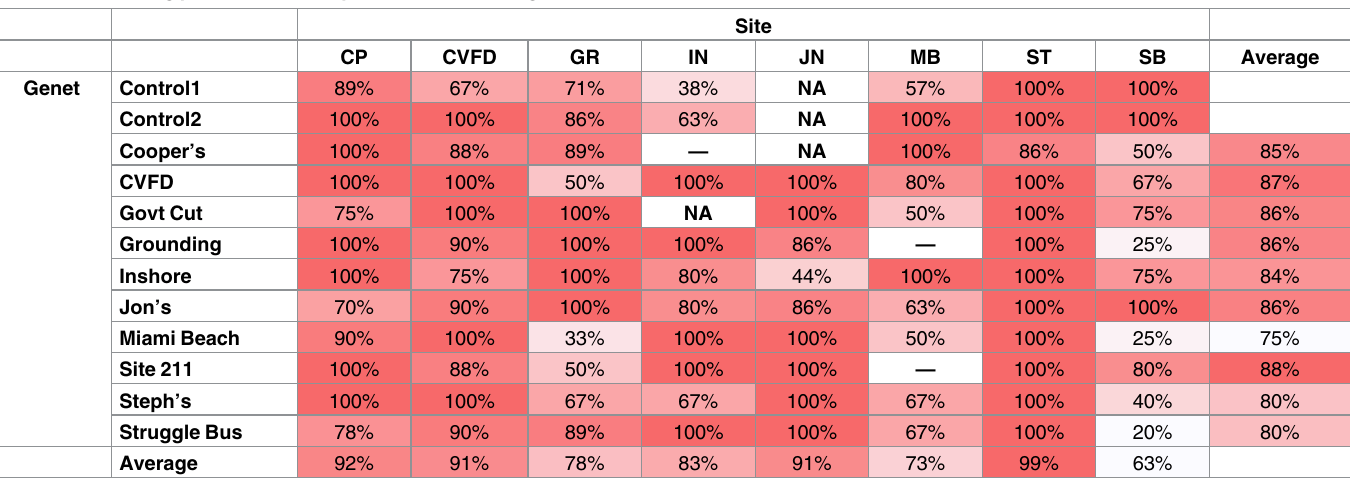
Table 4. Bleaching prevalenceof outplanted corals in